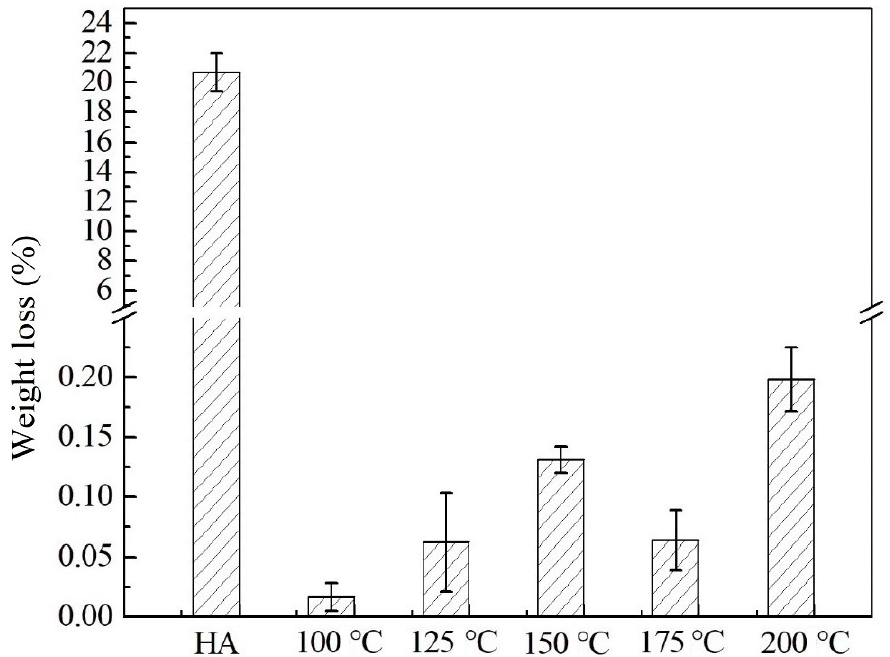
Figure 6. Weight reductions of both pure HA coating and HA/CS composite coating after ultrasonic cleaning for 10 min.